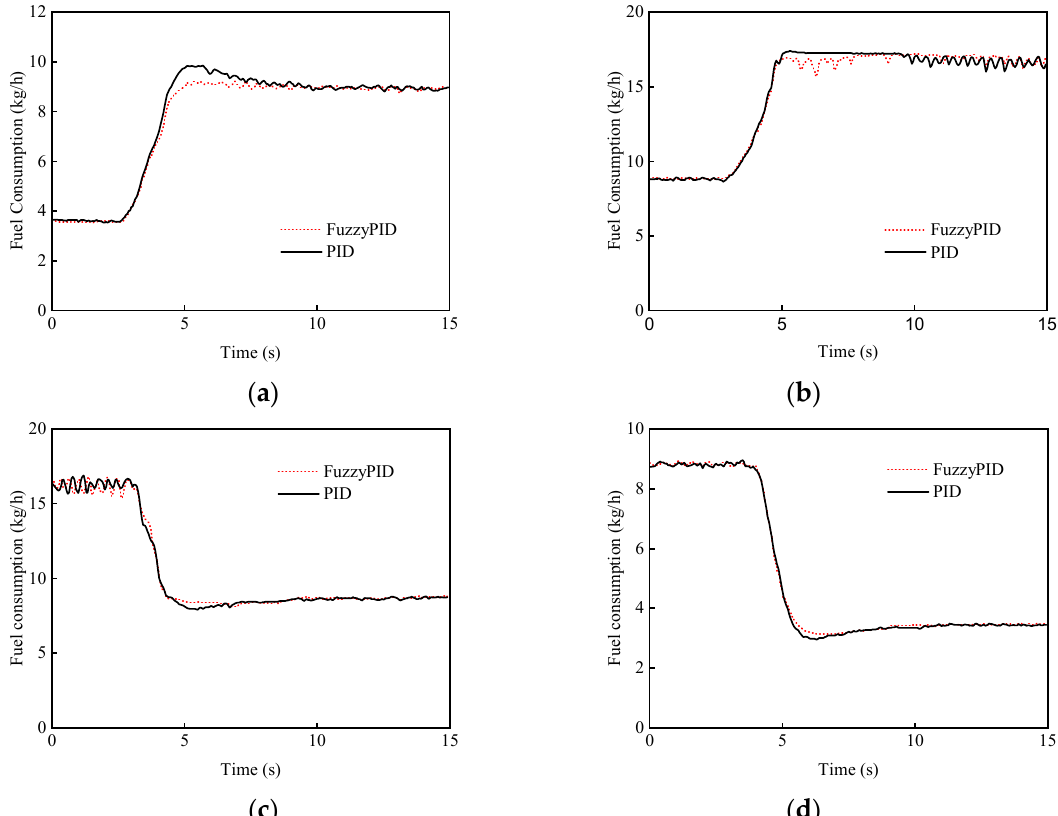
Figure 5. Engine fuel consumption characteristics in the process of working condition switching: ( a ) switching 1; ( b ) switching 2; ( c ) switching 3; ( d ) switching 4.